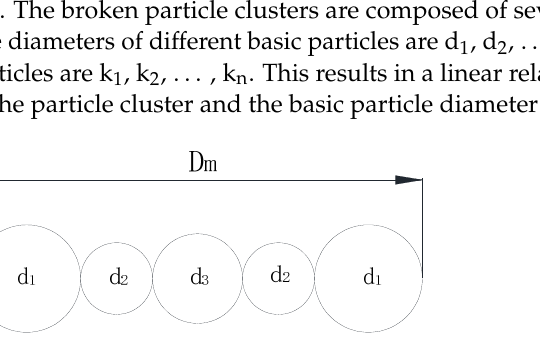
Figure 7. Particle cluster size.